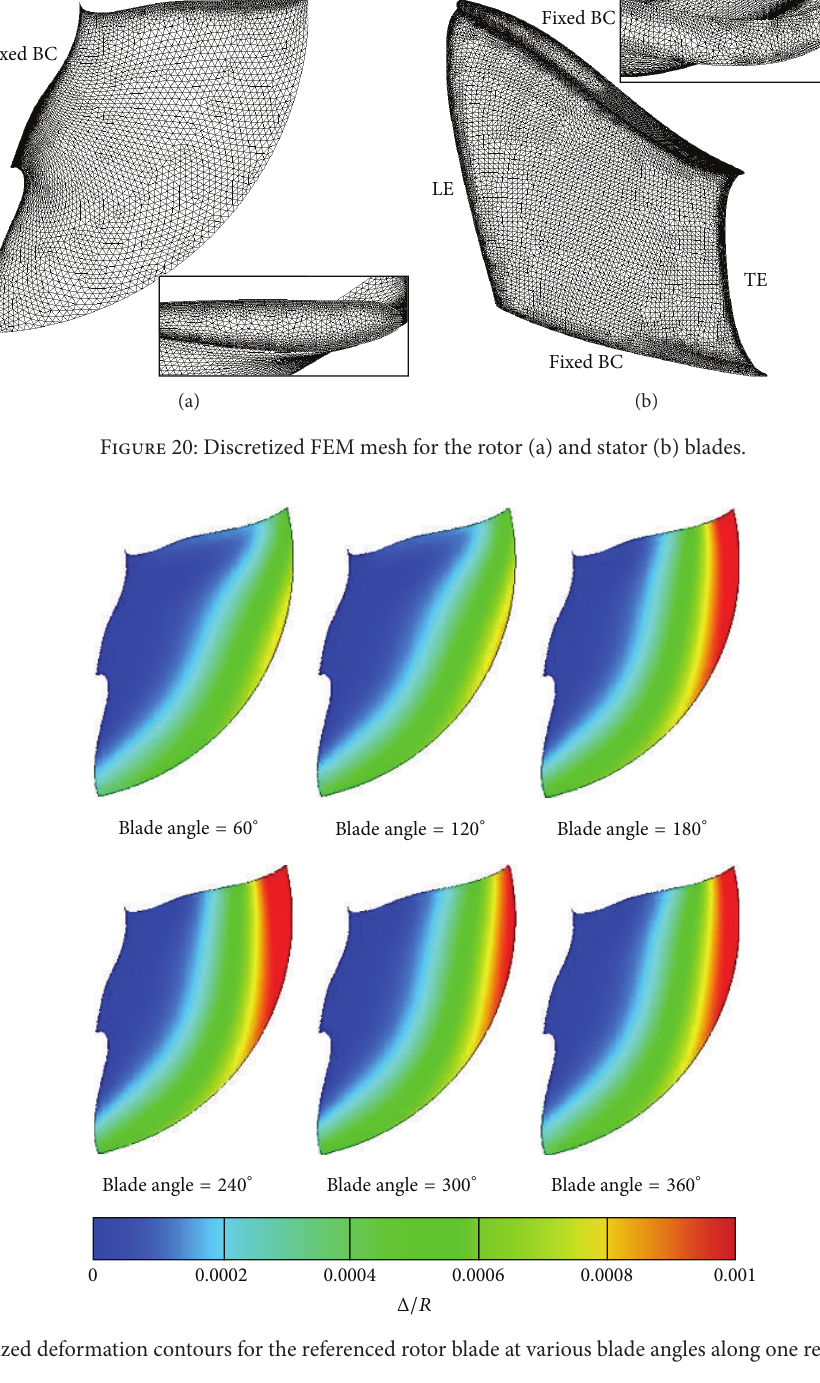
𝑅 = 0.85 m. The tip of the rotor blade undergoes small vibrations as it rotates. The maximum normalized tip deflec- tion is approximately 0.16%, or 1.34 mm, which is less